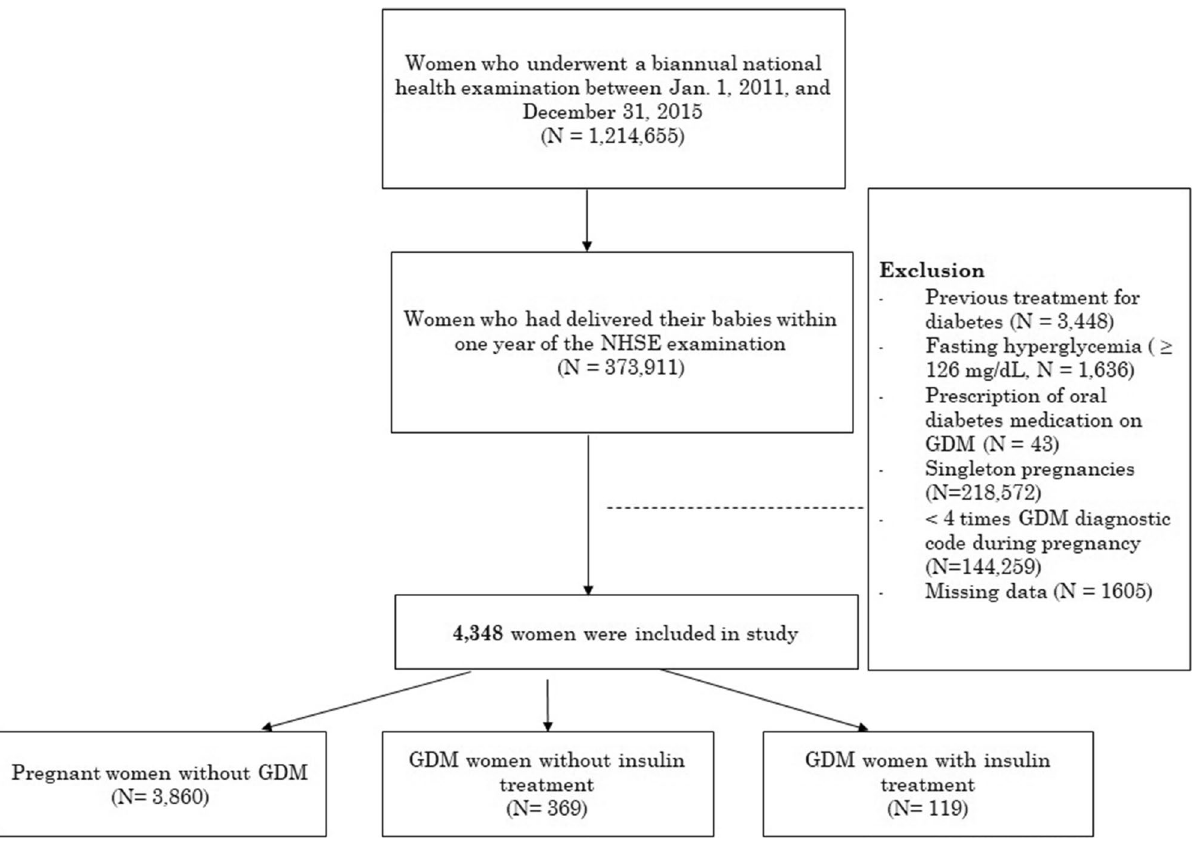
Figure 1. Flowchart of the study